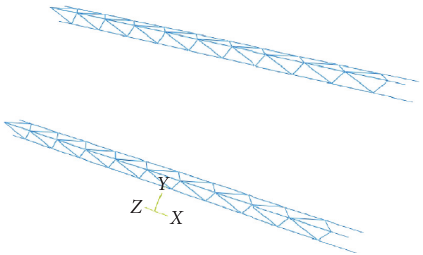
Figure 22: Model of the truss rebars.